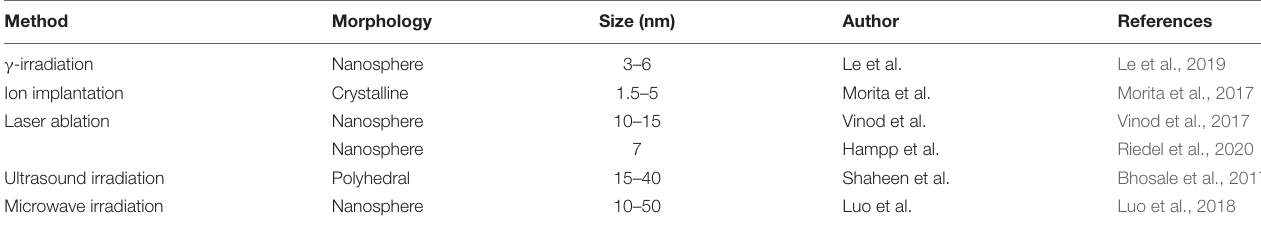
TABLE 1 | Physical synthesis of AuNPs with different morphology and